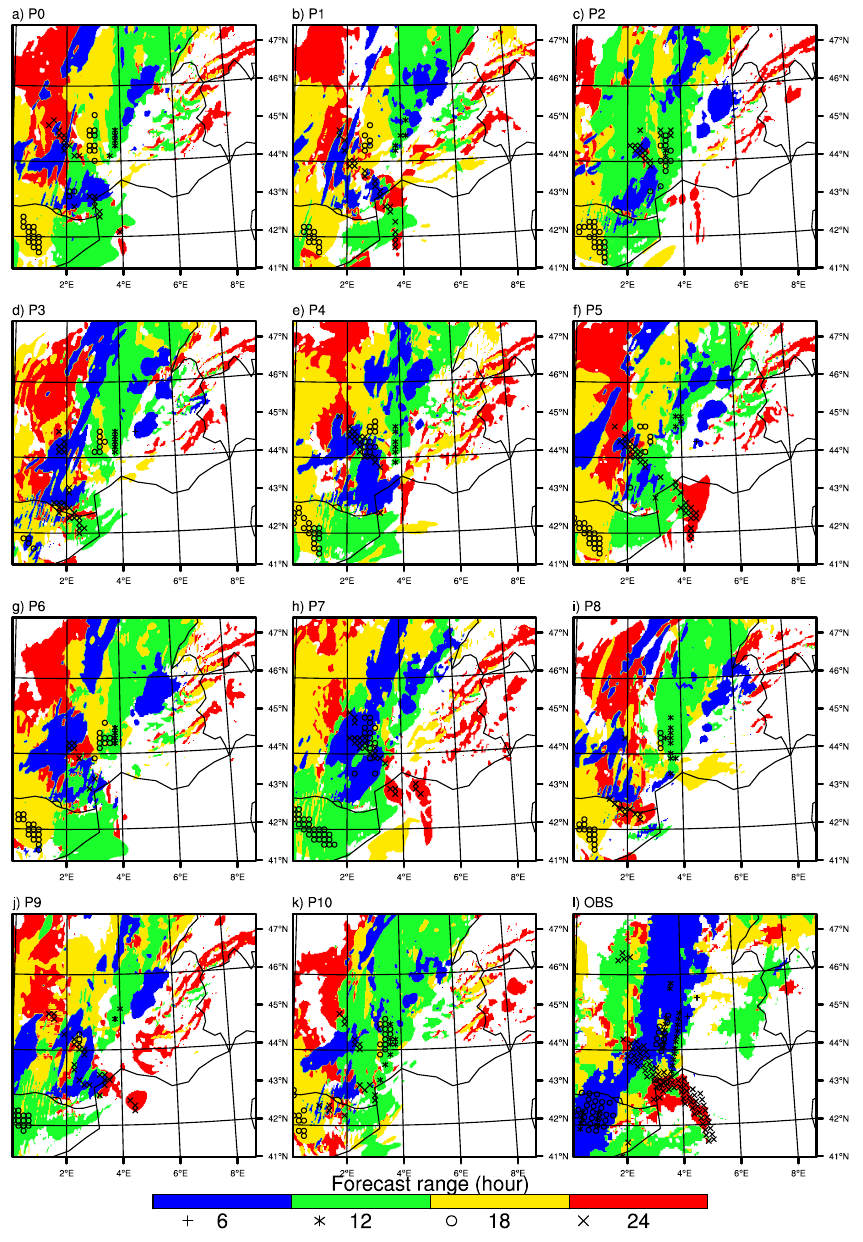
Fig. 8. Forecast range (hour) associated with SEVIRI 10.8µm BT less than 225K (shading) and AMSU-B DCT (symbols) from 18:00UTC, 1 November to 12:00UTC, 2 November 2008 for (a–k) AROME simulations and (i) MSG and AMSU-B observations.